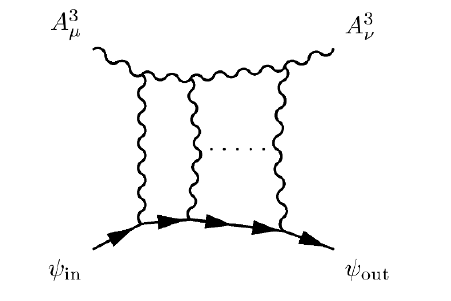
Figure 5. Ladder diagrams re-summed by the eikonal exponentiation, corresponding to a multi- Pomeron